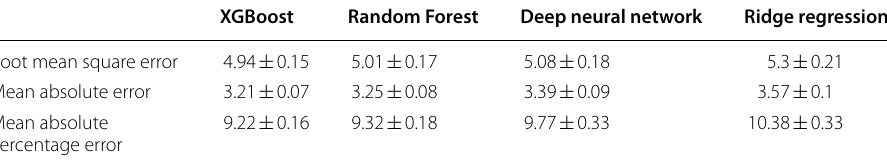
Table 4 Evaluations of machine learning models using the main dataset